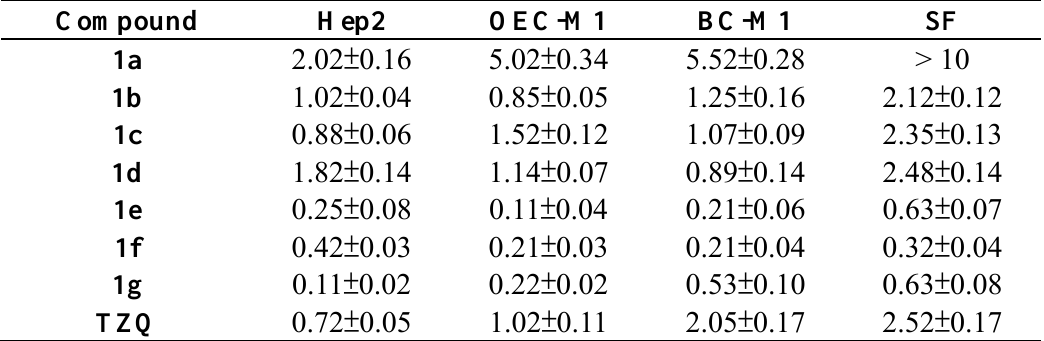
Table 1. The cytotoxicity of 1a-g (LC ,  M) by MTT assay in three cancer cell lines and 50 normal skin fibroblast (SF). The MTT assay was used to determine the cell viability after an additional 24 hr of culture. Data were from triplet wells and are representative of three separate